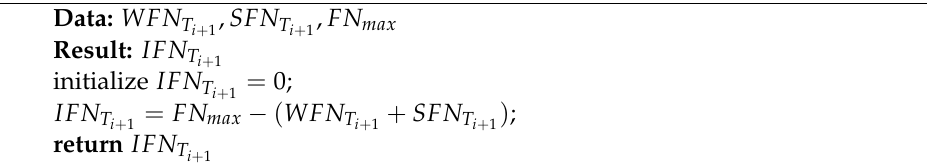
Algorithm 4: f ind _ IFN : determining the number of